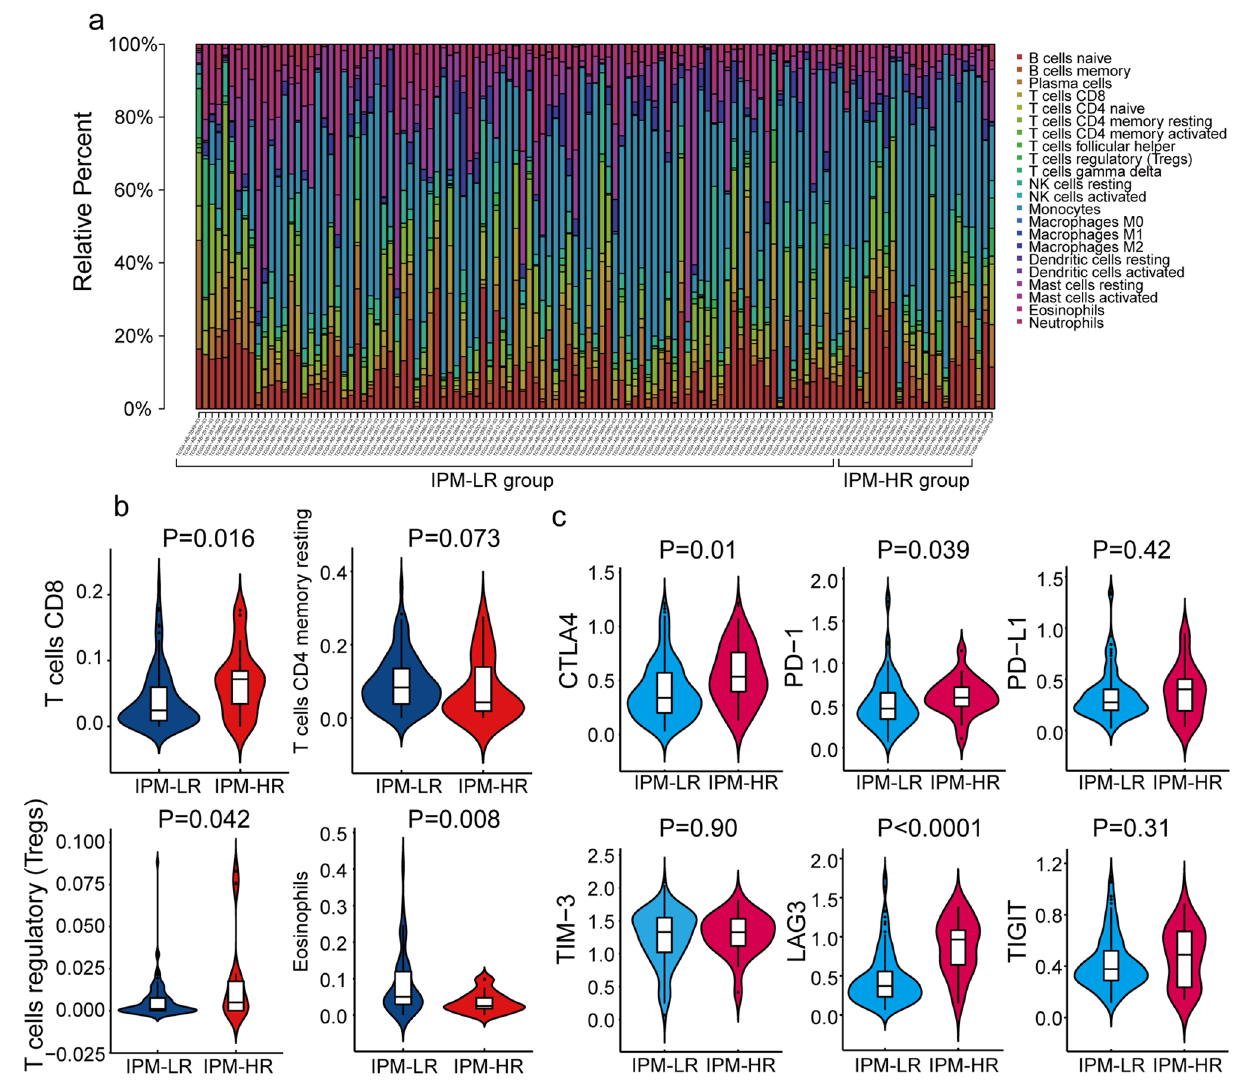
cells infiltration in IPM-HR and IPM-LR patients; ( b ) Violin plots showing significantly different proportions of immune cells between IPM-HR and IPM-LR patients; ( c ) Violin plots showing the expression of different immune checkpoint molecules between IPM-HR and IPM-LR